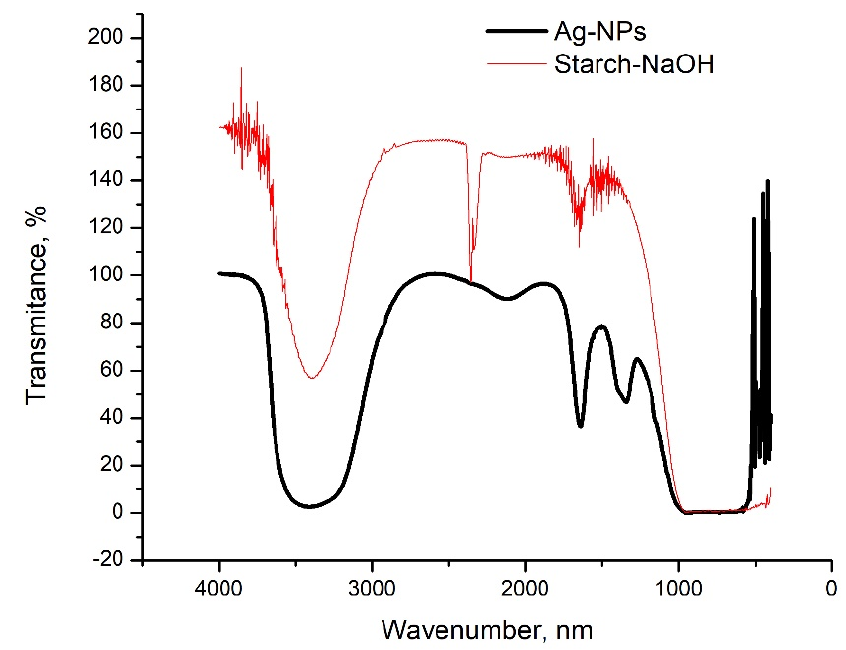
Figure 5. FT-IR spectra were recorded for Ag-NPs and Starch-NaOH. In both spectra, in the range of 3200–3550 cm − 1 , a vibration appears specific to the O-H bond. Moreover, at the wavenumber 2121 cm − 1 , a peak specific to the vibration of the aliphatic C-H bond appears. More significantly, a peak specific to the vibration of the C=O bond appears in the sample with starch and NaOH only, at the wavenumber of 1645 cm − 1 .